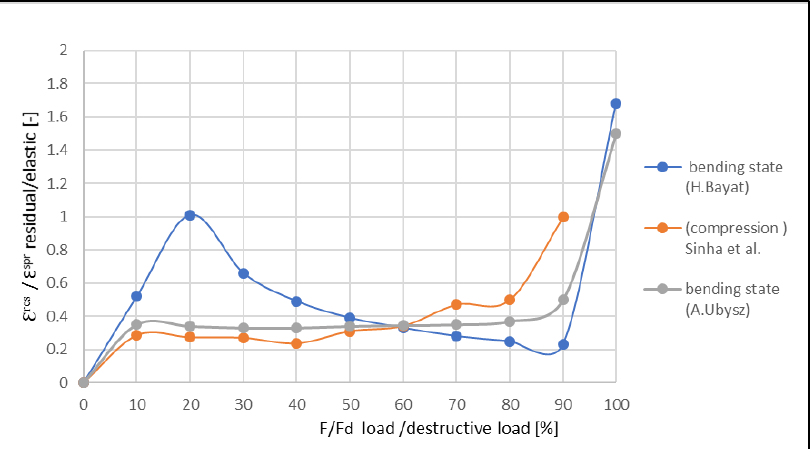
Figure 17. Comparison of the results from the literature [1,20,22] with those obtained by the authors.